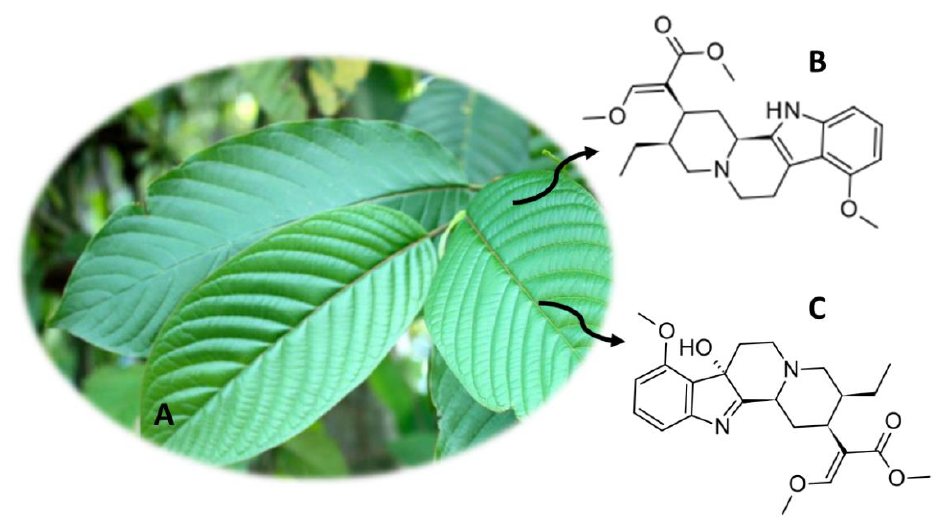
Figure 8. M. speciosa ( A ) and the main compounds mitragynine ( B ) and 7-hydroxymitragynine ( C